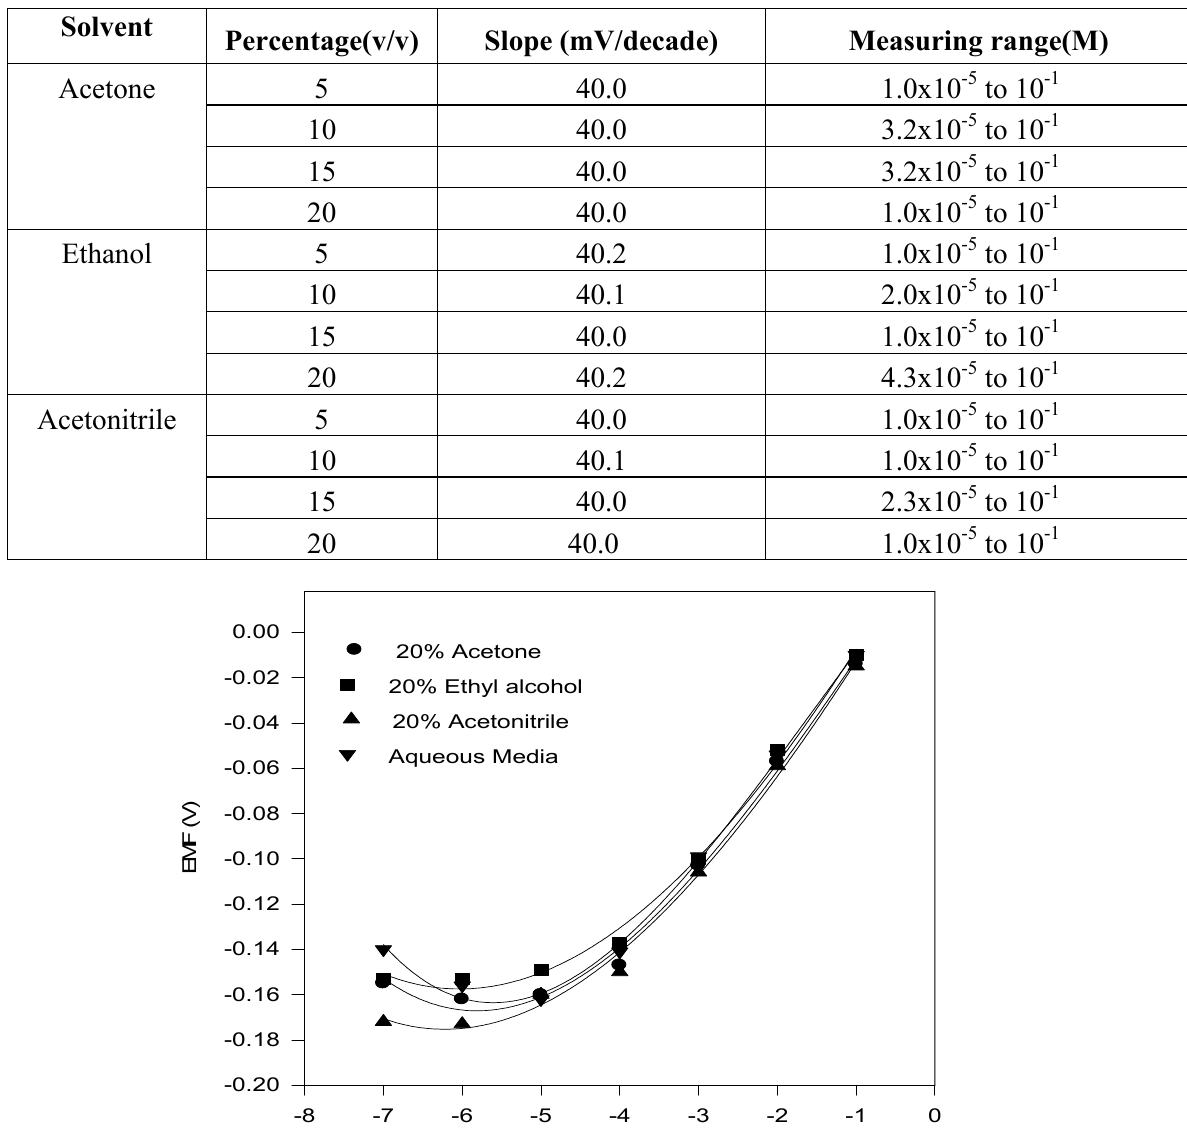
Table 3. Effect of partially non-aqueous media on the working of Sm (III) selective electrode.